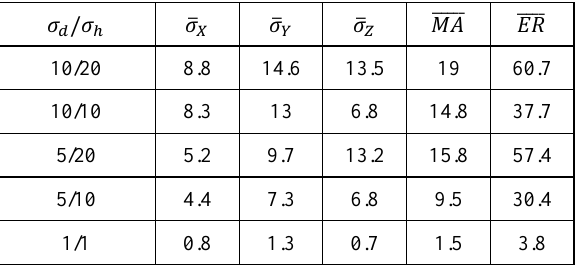
Tab.5: Simulation result on short pole configuration for different distance and height measurement accuracies, 𝜎 𝑑 and 𝜎 ℎ , respectively. Given are average values for coordinate standard deviations, major semi-axis of error ellipsoids (MA), and external reliability (ER). Units are